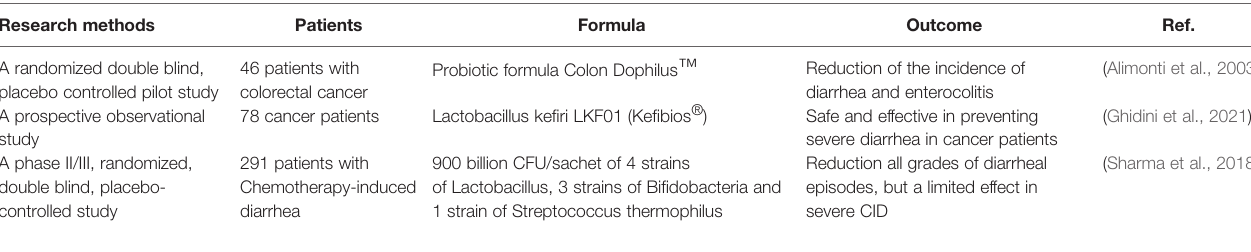
TABLE 2 | Preclinical study outcomes of probiotics interventions upon CPT11 chemotherapy. Research